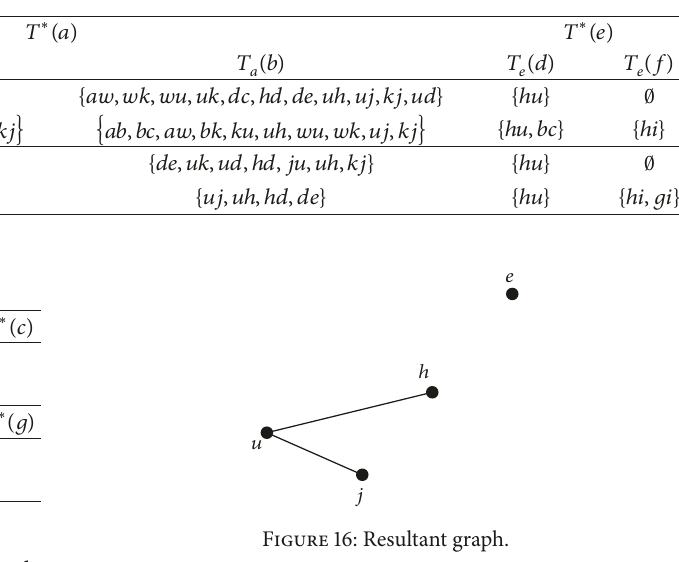
Table 3: (𝐴∧ E 𝐵) correlation table.